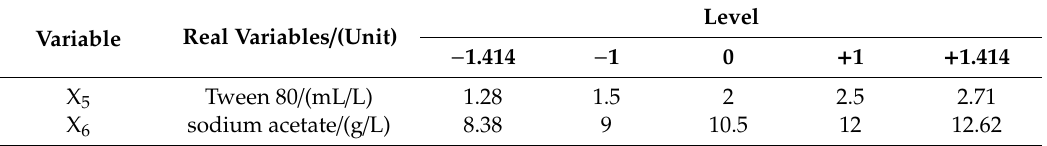
Table 3. Range of di ff erent factors investigated with the central composite design